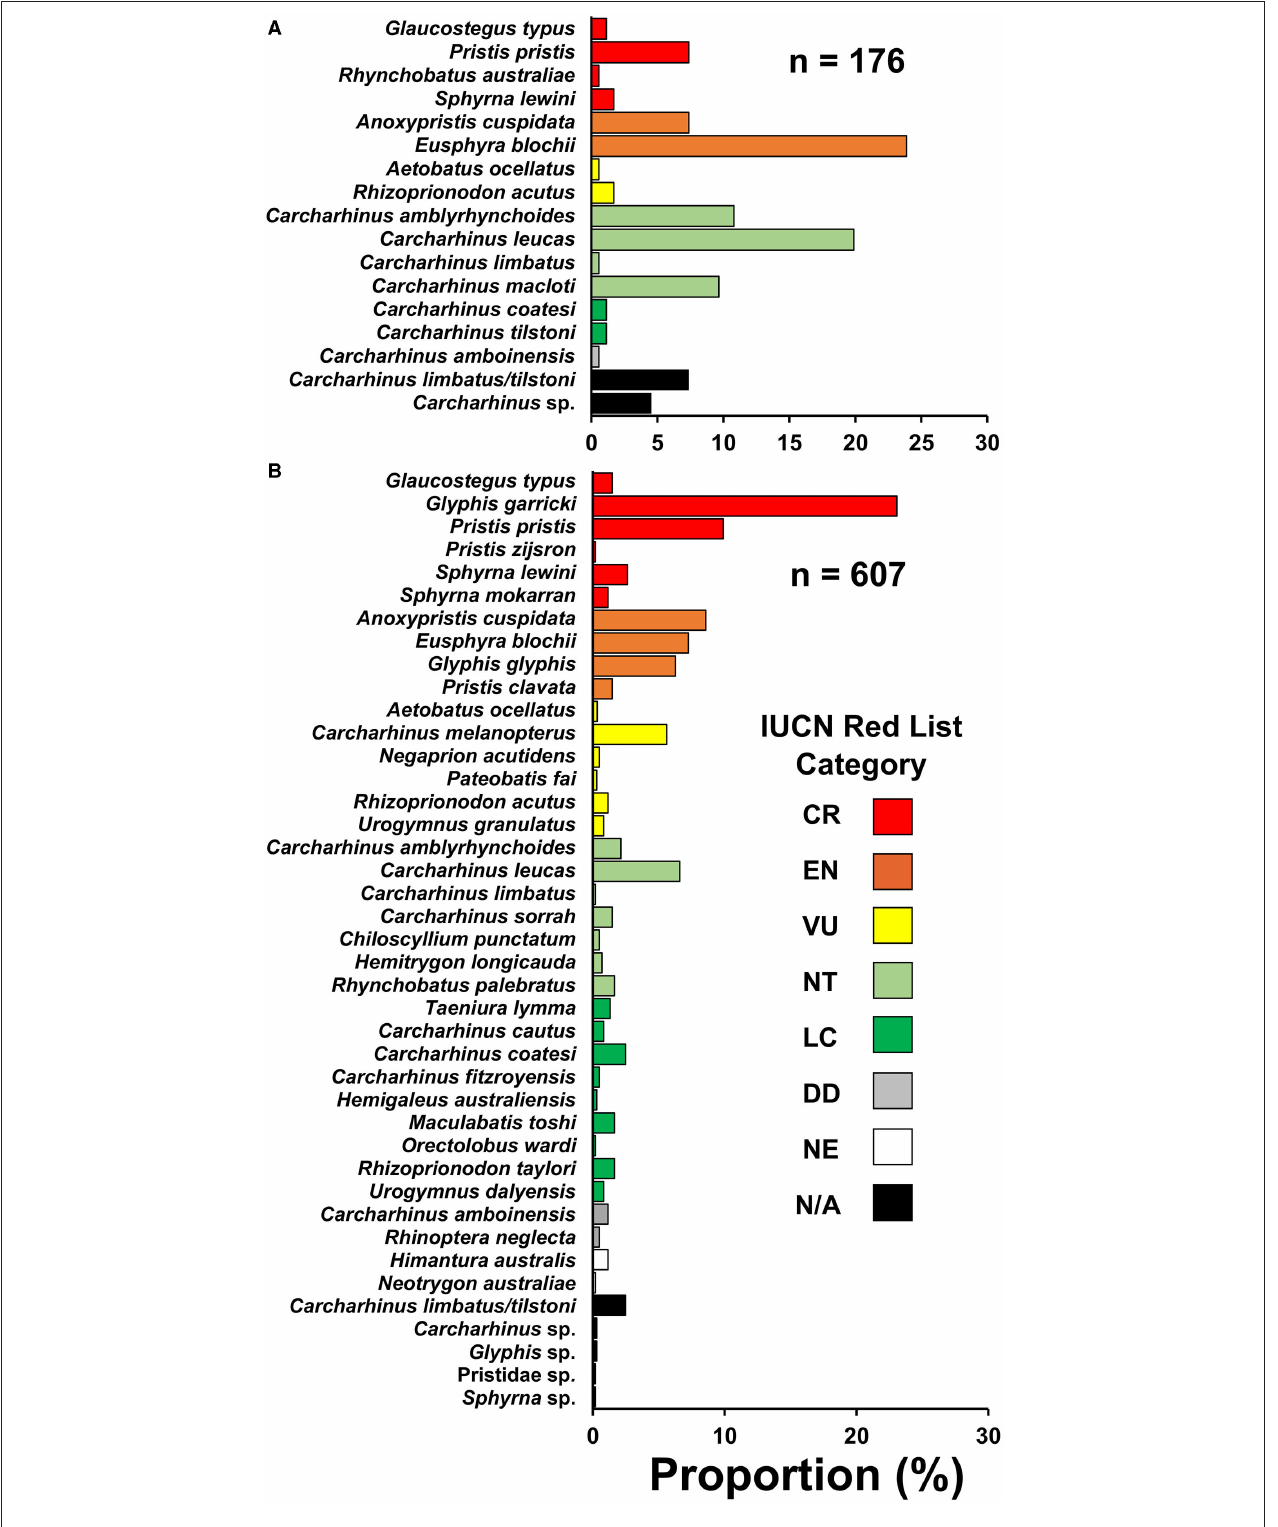
FIGURE 2 | Species compositions encountered from small-scale fisheries in the (A) northern region and (B) southern region of Papua New Guinea. Species are categorized into their current IUCN Red List category (IUCN 2021). CR, critically endangered; EN, endangered; VU, vulnerable; NT, near threatened; LC, least concern; DD, data deficient; NE, not evaluated; N/A, not applicable.